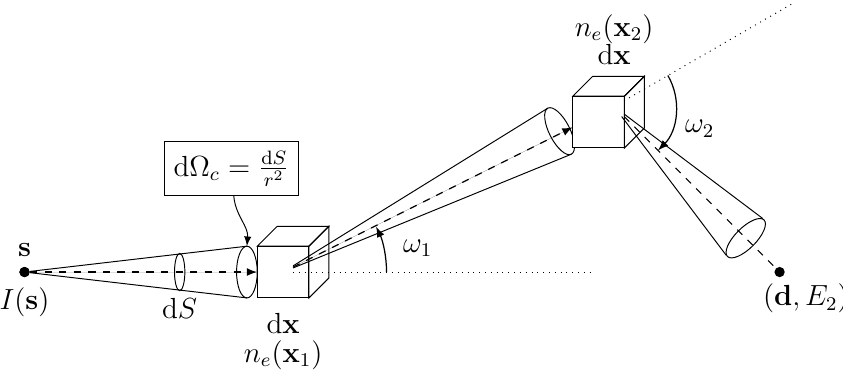
Figure 3. Geometry of the Compton effect for two successive scattering events.